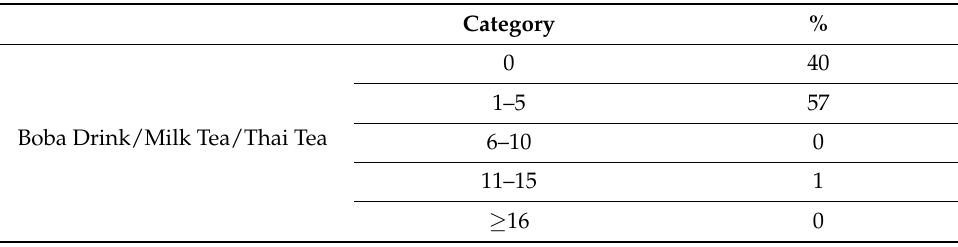
Table 3. Frequency of online orders based on types of food and